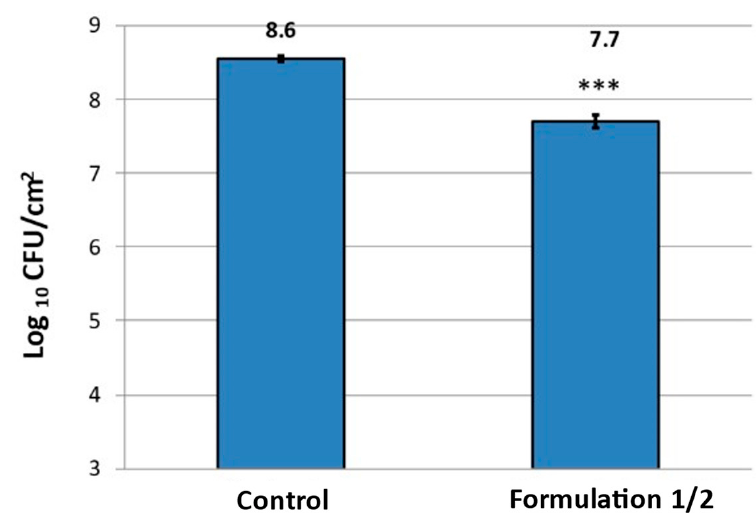
Figure 5. Reduction of P. fluorescens on the cellulose substrate after treatment for biofilm removal. P. fluorescens grown for 48 h to form biofilms on cellulose substrates were washed for 1 h with Formulation 1/2 or not treated (control). Bacteria were extracted from biofilms on the cellulose substrate via mild ultrasonication. Resulting bacteria suspensions were serially diluted, and the concentration of viable bacteria was determined via colony forming unit counting. Concentration of viable P. fluorescens is expressed as mean log CFU/cm 2 ± SD. *** p < 0.001 ( n =